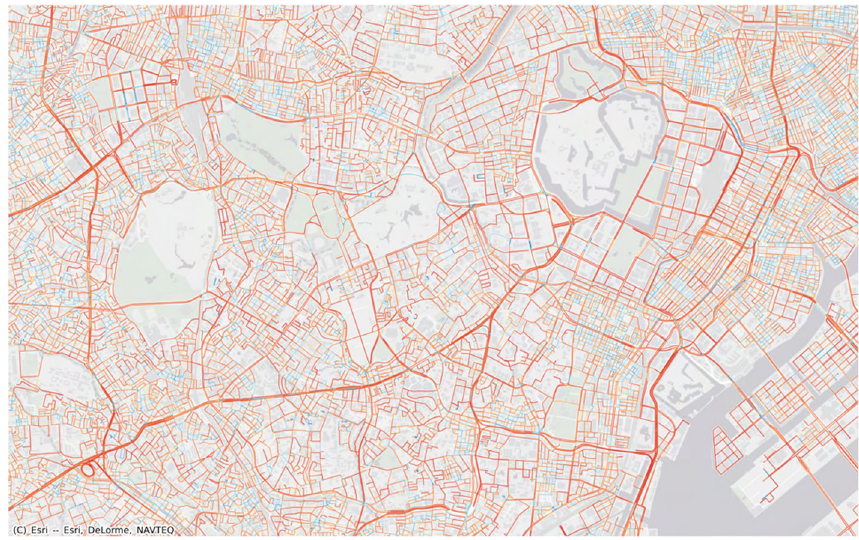
Fig. 8 Close-up map of the edge weights capturing node similarity using ω 1 , 200 m subgraphs, and all variables (lowest error combination). Dark red indicates minimal similarity, dark blue indicates the maaximum similarity, colors diverge at the mean similarity value. Coherent patterns are few and small within this central